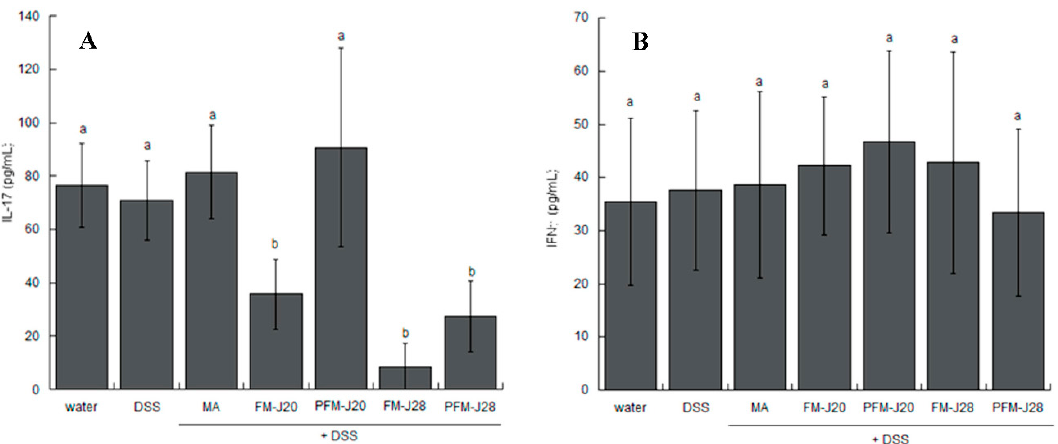
Figure 4. The effect of DSS and fermented milk administration on IL-17 ( A ) and IFN γ ( B ) determined by ELISA of colonic mucosa at Week 10. Different letters show statistical differences ( p < 0.05) among treatments according to the Kruskal–Wallis test. The values are medians ± interquartile ranges ( n = 5). The binding of IL-10 to its receptor triggers phosphorylation-dependent activation of the transcription factor STAT3, which upregulates the gene expression of members of the SOCS family and proinflammatory cytokines such as TNF α and macrophage inflammatory protein 2. However, this process is possibly inhibited by the presence of bacteria or other components, such as EPS